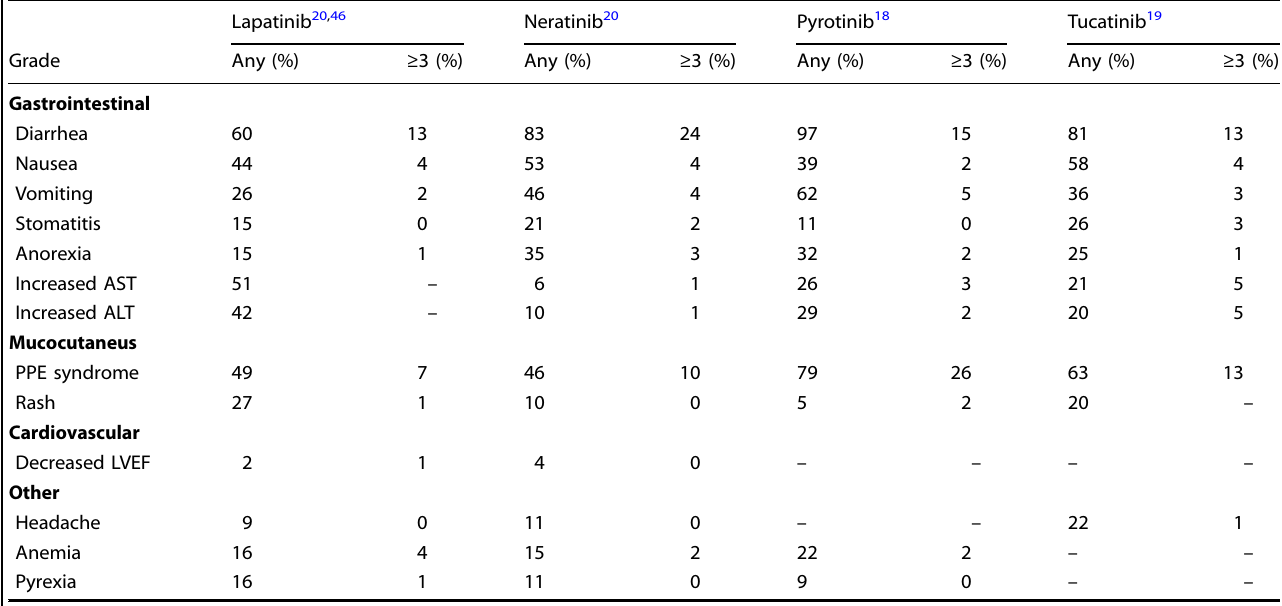
Table 4. Selected adverse events and laboratory abnormalities from phase 2/3